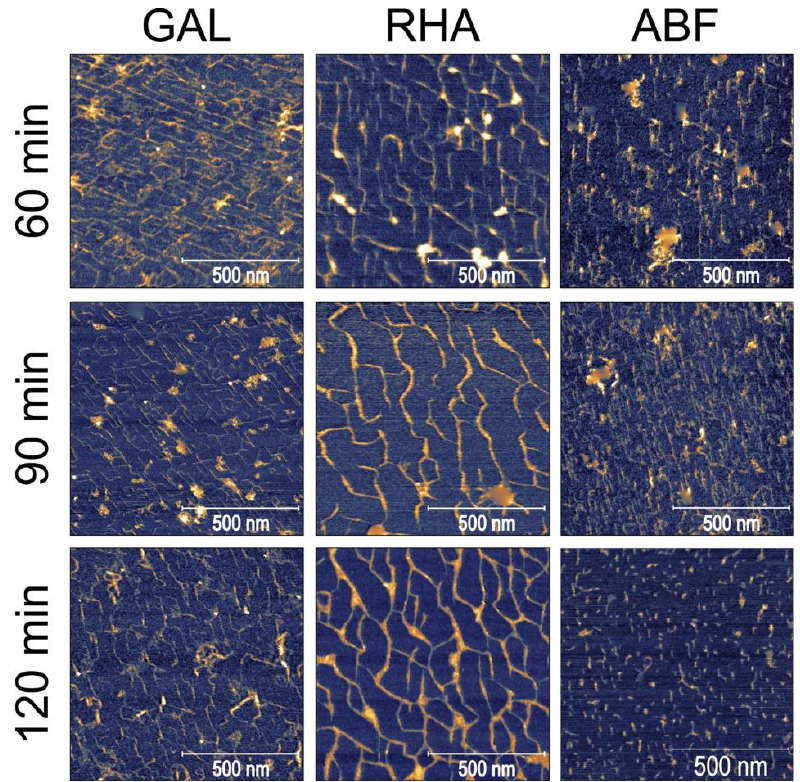
Figure 2. Sample images of DASP treated with GAL, RHA and ABF with respect to the duration of enzyme treatment.